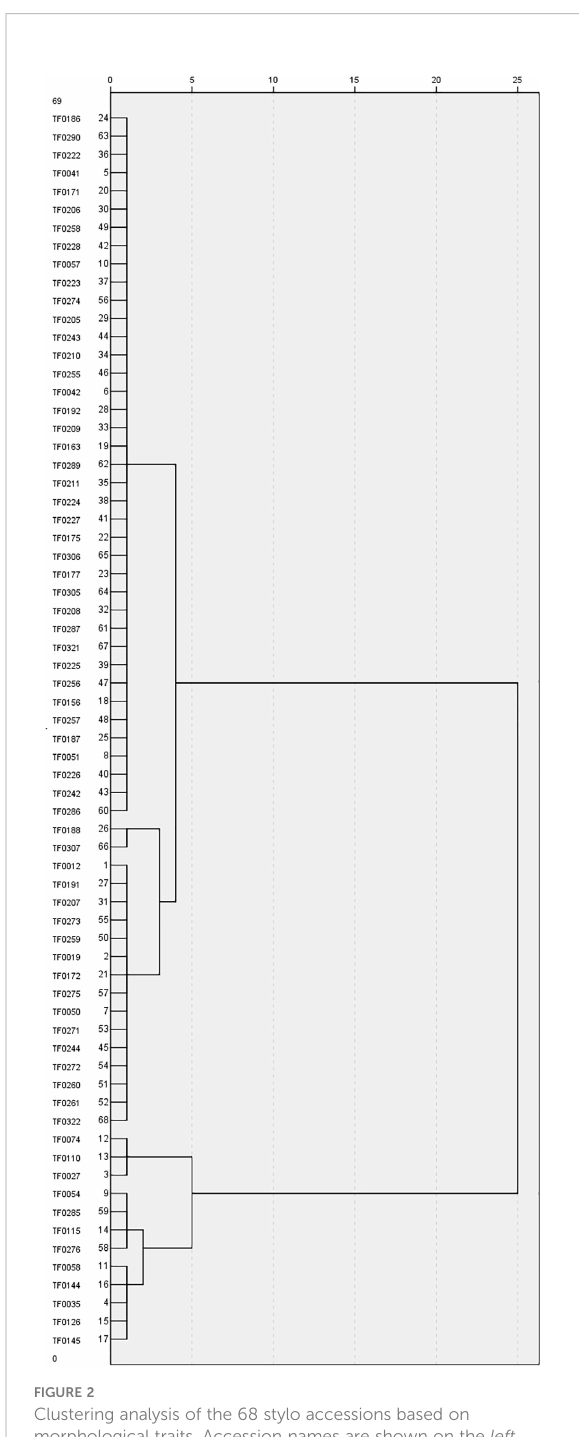
FIGURE 2 Clustering analysis of the 68 stylo accessions based on morphological traits. Accession names are shown on the left side of the